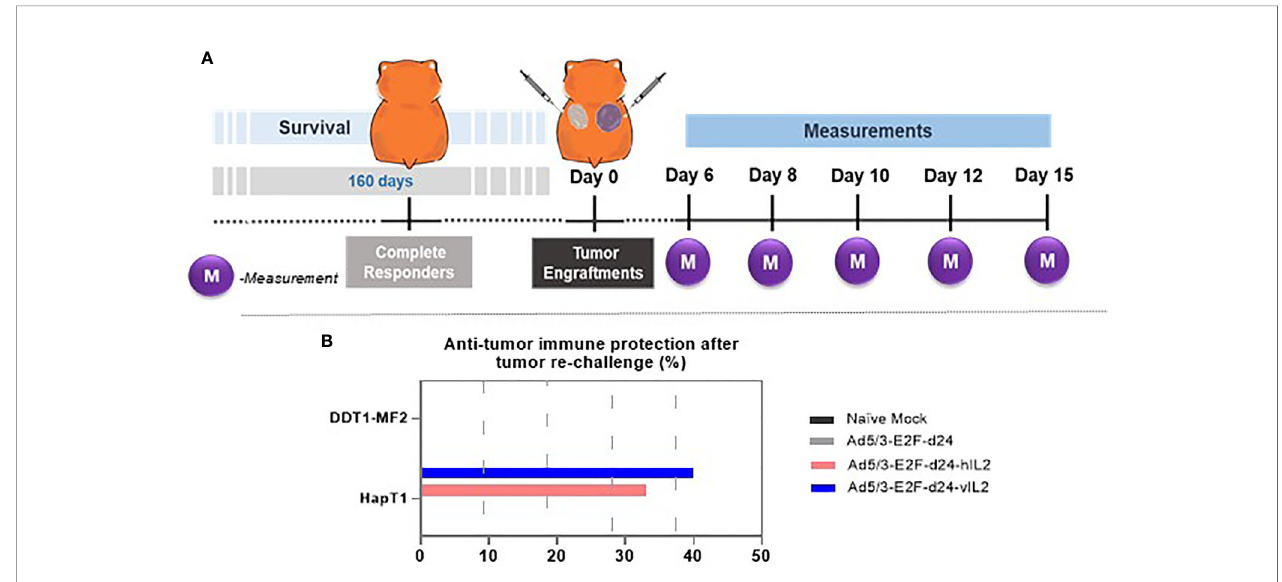
FIGURE 6 | Anti-tumor immune protection experiment in complete responders. (A) Experimental design illustration of tumor engraftments and measurements. (B) Anti-tumor immune protection provided by the treatment groups after the tumor